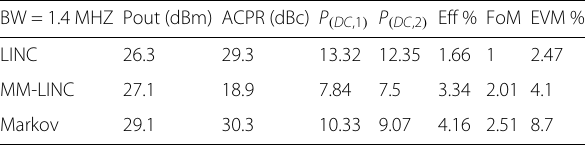
Table 5 Experimental LINC and mode-multiplexing results BW = 1.4